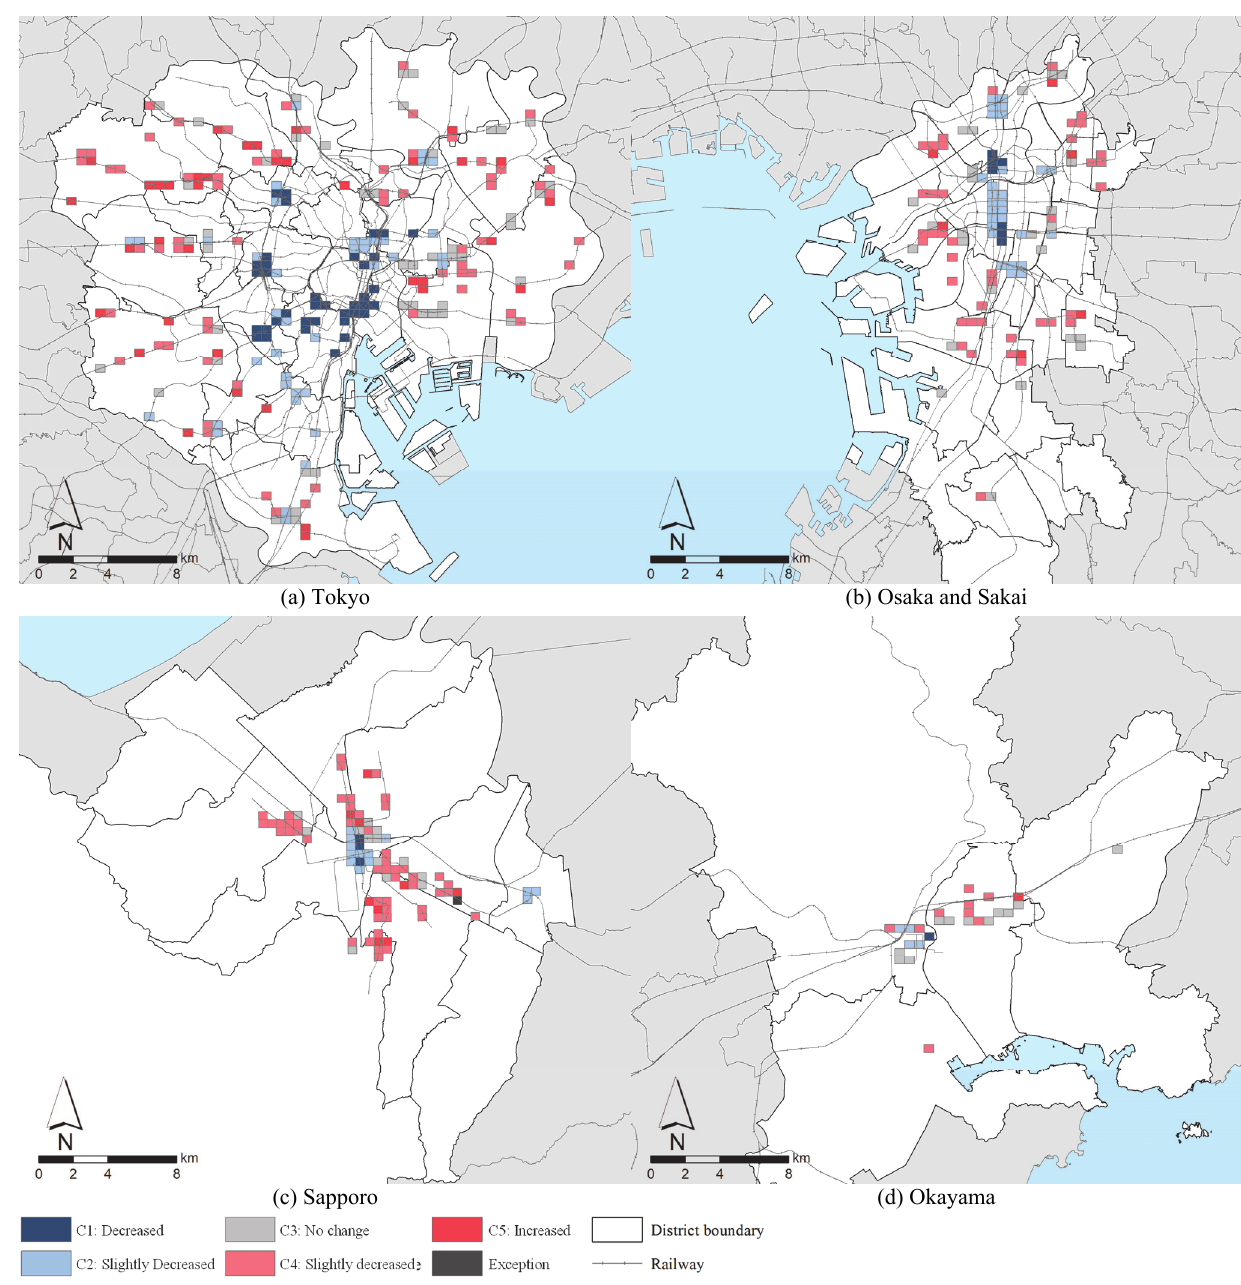
Figure 10 . Spatial distribution of clusters in four